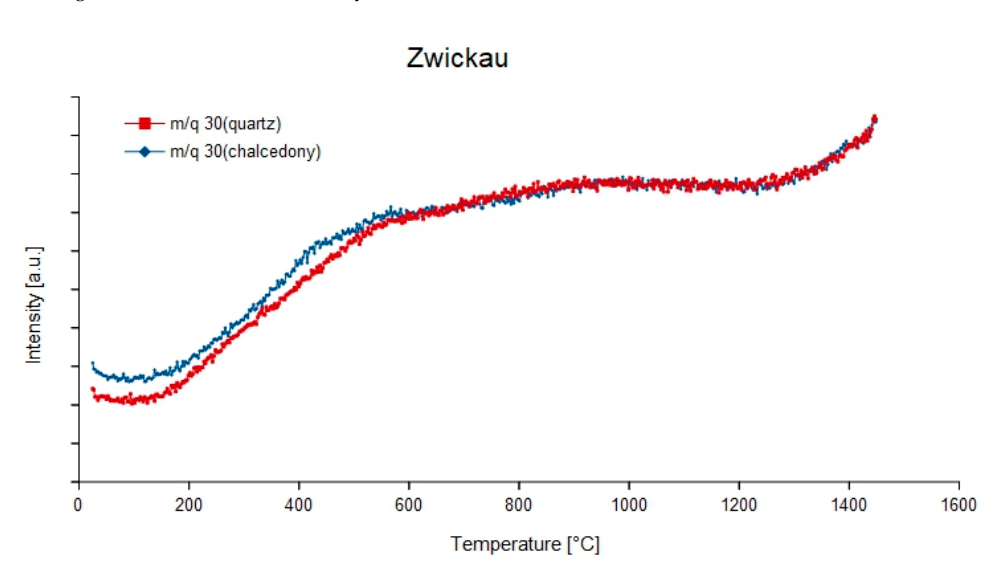
Figure 7. Continuous degassing curves of mass-charge ratio 30 ( 14 N 16 O) of the quartz and chalcedony parts in the agate from Zwickau, Germany.